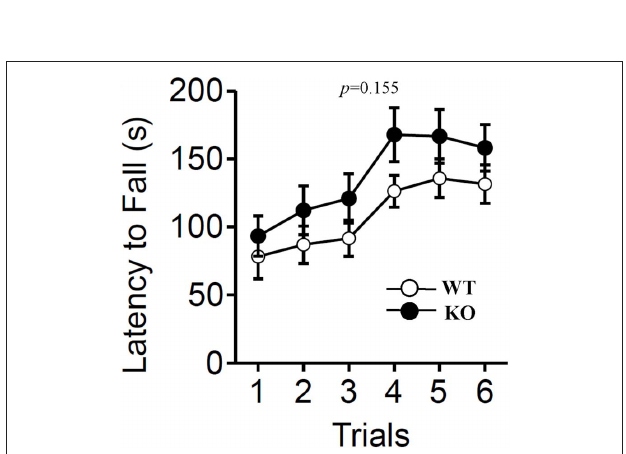
Figure 5 | elevated plus maze test. Mice ( n = 20 each) completed the elevated plus maze test. The number of arm entries (A) , percentage of entry into open arms (B) , distance traveled (C) , and time spent in open arms (D) were recorded. Data are presented as mean ± SEM. p -Values were calculated by Student’s t -test.